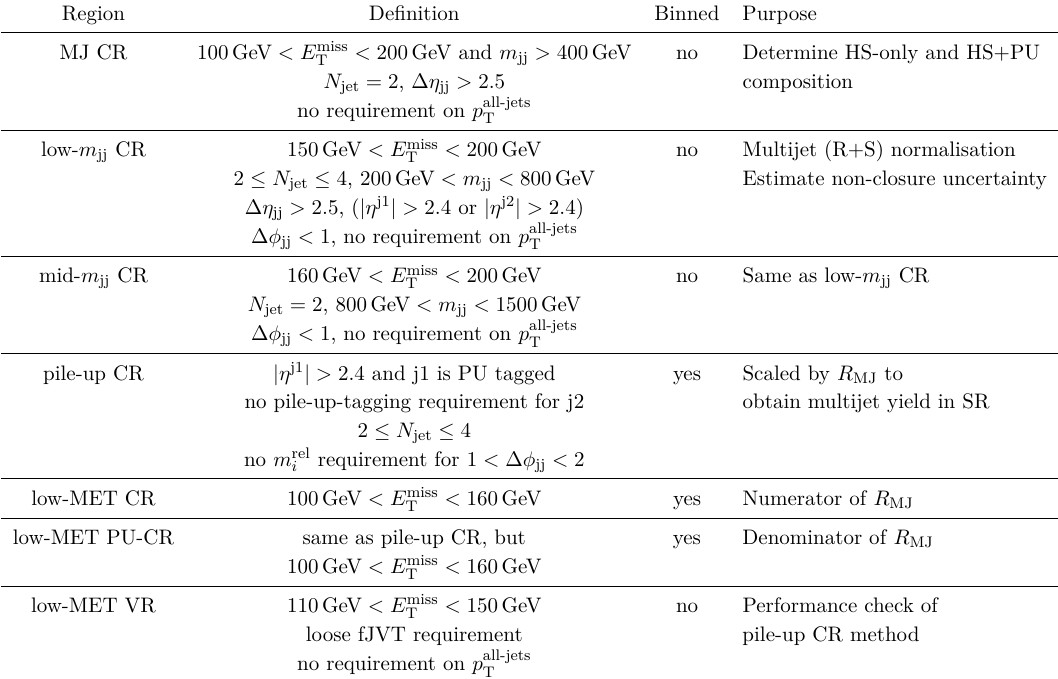
Table 3. Control regions used for the multijet background estimation. Only changes relative to the SR selection are given. The third column shows if a the control region is binned in ∆ φ m jj like the signal region. Except for the MJ CR, which uses single-jet-triggered data, all control regions use E miss